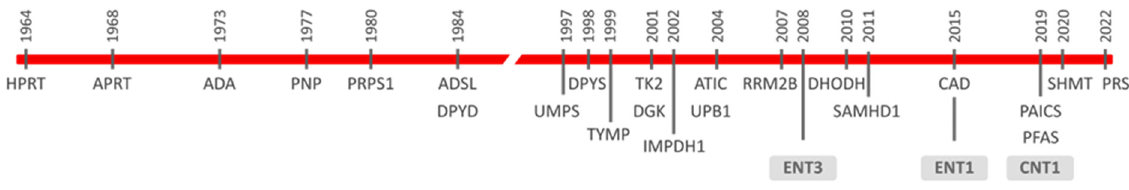
Figure 1. Chronogram of the discovery of rare diseases caused by mutations in genes encoding nucleotide metabolism-related proteins. Nucleoside transporters (ENT3, ENT1, and CNT1) are boxed. Full names of all enzyme acronyms are introduced in the text.